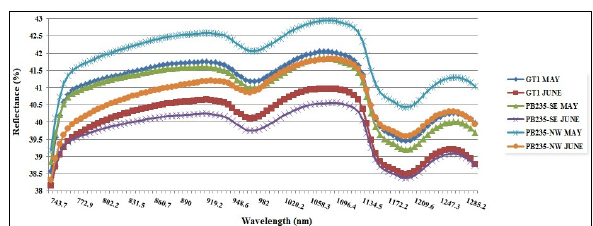
Figure 11. Spectral behaviour in leaf scale from 740 to 1,300nm, for May and June, of the Rubber trees stands: GT1, PB235-SE and PB235-NW